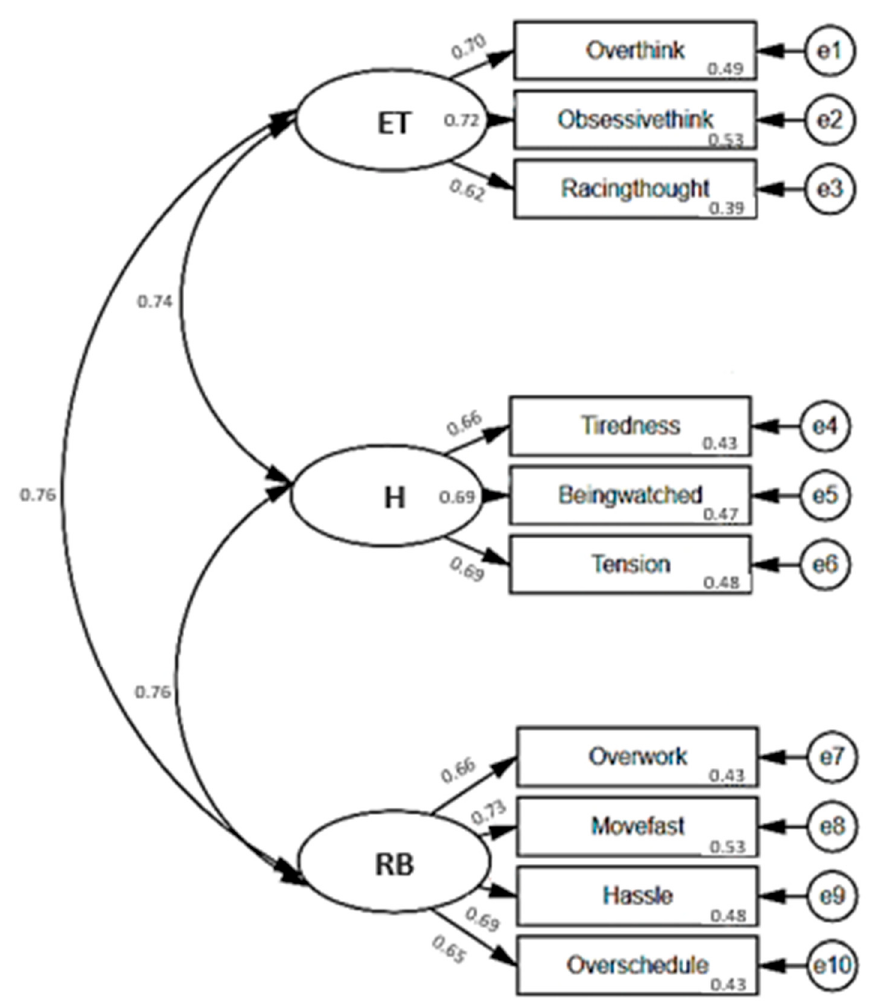
Figure 2. Con fi rmatory factor analysis path diagram for the three domains of BOS ( n = 739). ET: Figure 2. Confirmatory factor analysis path diagram for the three domains of BOS ( n = 739). Excessive thinking; H: Hypersensitivity; RB: Restless behavior. ET: Excessive thinking; H: Hypersensitivity; RB: Restless